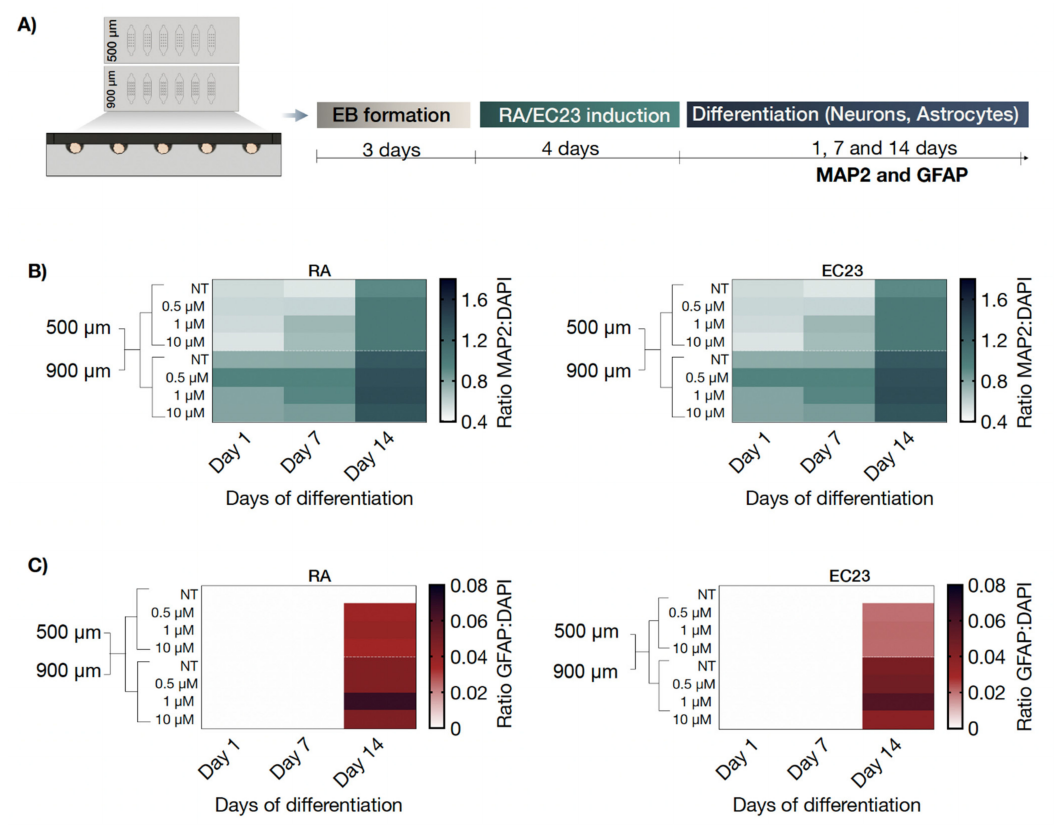
Figure 7. ( A ) Workflow of the microfluidic differentiation protocol by using single-sized microfluidic biochip arrays (500 and 900 µ m well diameters) including on-chip EB generation, exposure to retinoic acid (RA) and EC23, as well as differentiation into neurons and astrocytes. Influence of two EB sizes on ( B) neuronal (MAP2, green) and ( C ) astrocytic (GFAP; red) differentiation marker expression relative to cell nuclei (DAPI) during 14 days after a 4-day exposure of RA or EC23 and 14 days of differentiation, n = 1 ±